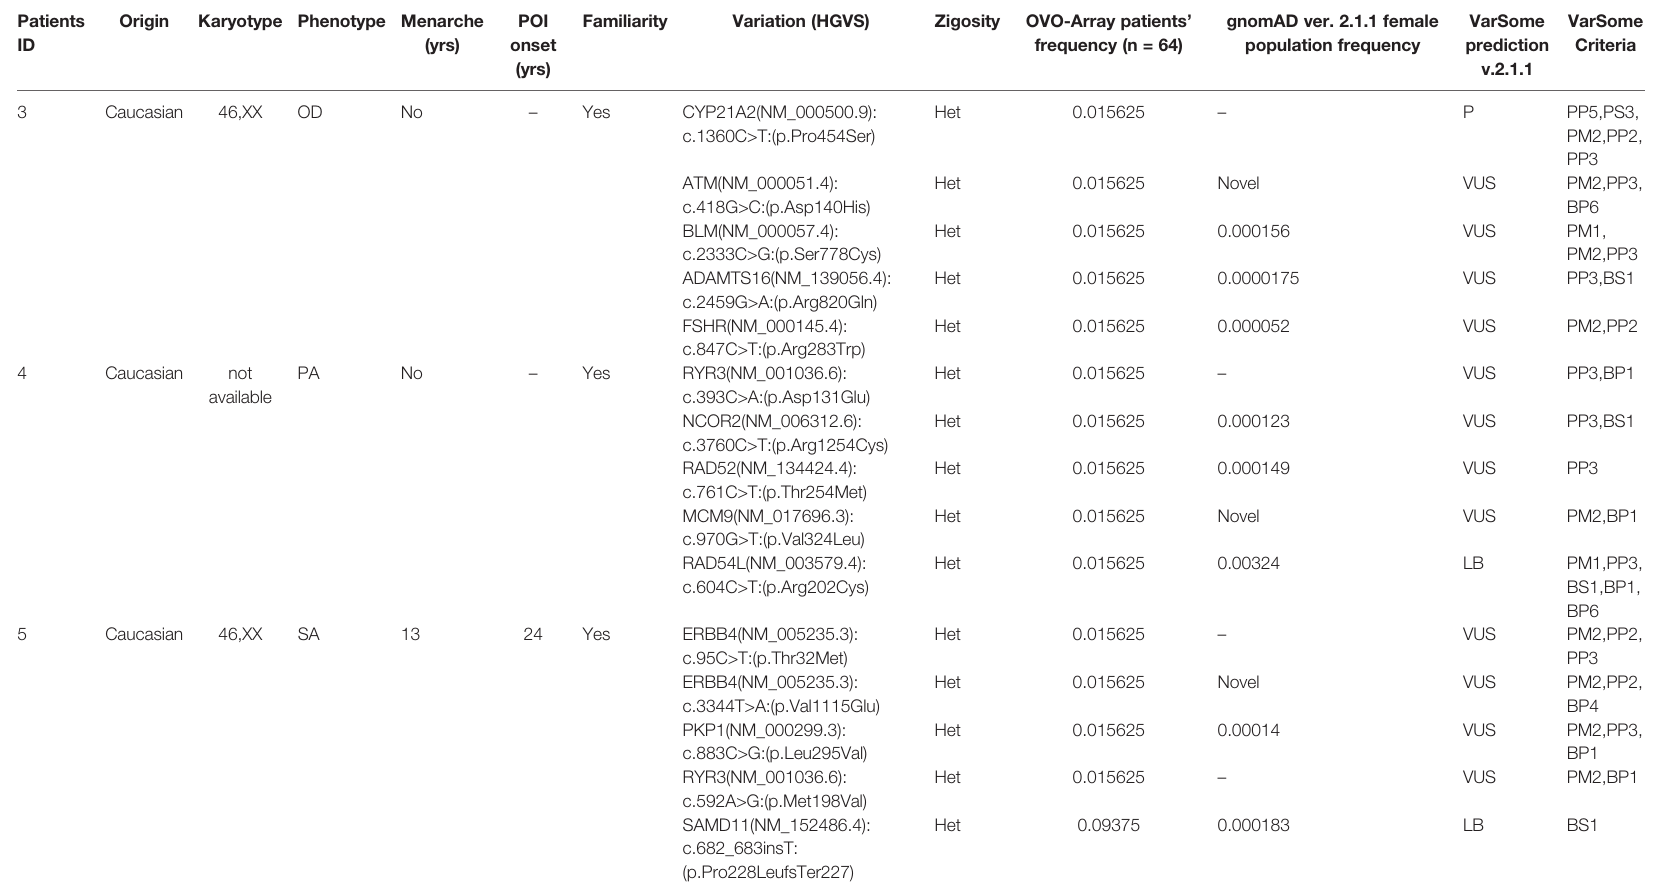
TABLE 2 | Correlation among severity, phenotype and pathogenicity predictions in patients with 5 variants in potentially POI